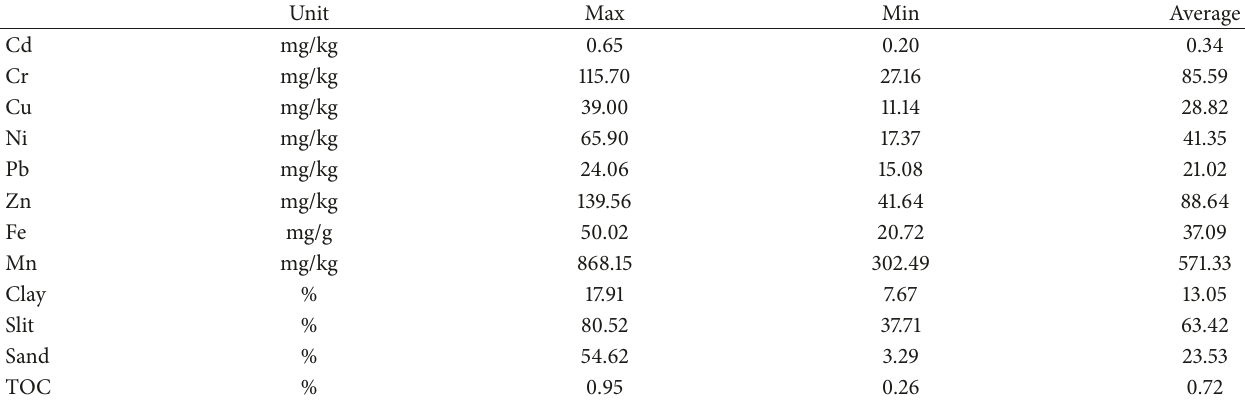
Table 1: The concentrations of heavy metals and physiochemical properties in the sediments. Unit Max Min Average 0.65 0.20 0.34